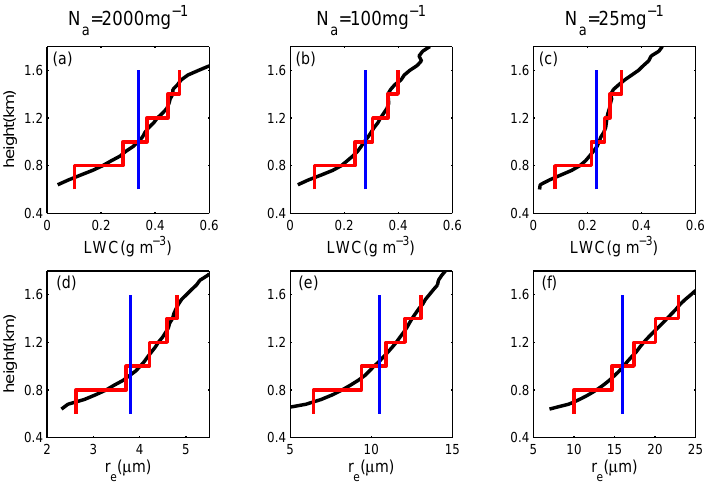
Fig. 8. (a, b, c) Idealized LWC profiles and (d, e, f) idealized r e profiles for the input of the SBDART model. Black lines: LES model results. Red lines: vertically inhomogeneous clouds that have 5 sublayers covering the height range z =600–1600m; profiles are based on LES simulations. Blue lines: vertically homogeneous clouds. Note that the two clouds have the same LWP. We vary the r e of the vertically homogeneous cloud (shown here is one of the values used in the SBDART model for each case) until it has the same radiative forcing as the vertically inhomogeneous